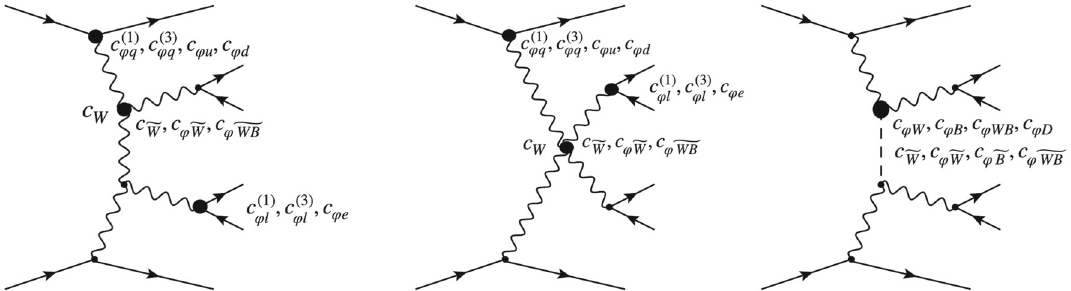
Fig. 1 EFT corrections modifying the quartic (left panel) and triple (middle panel) gauge couplings in vector-boson scattering, as well as the the t -channel Higgs exchange contribution (right panel) and the